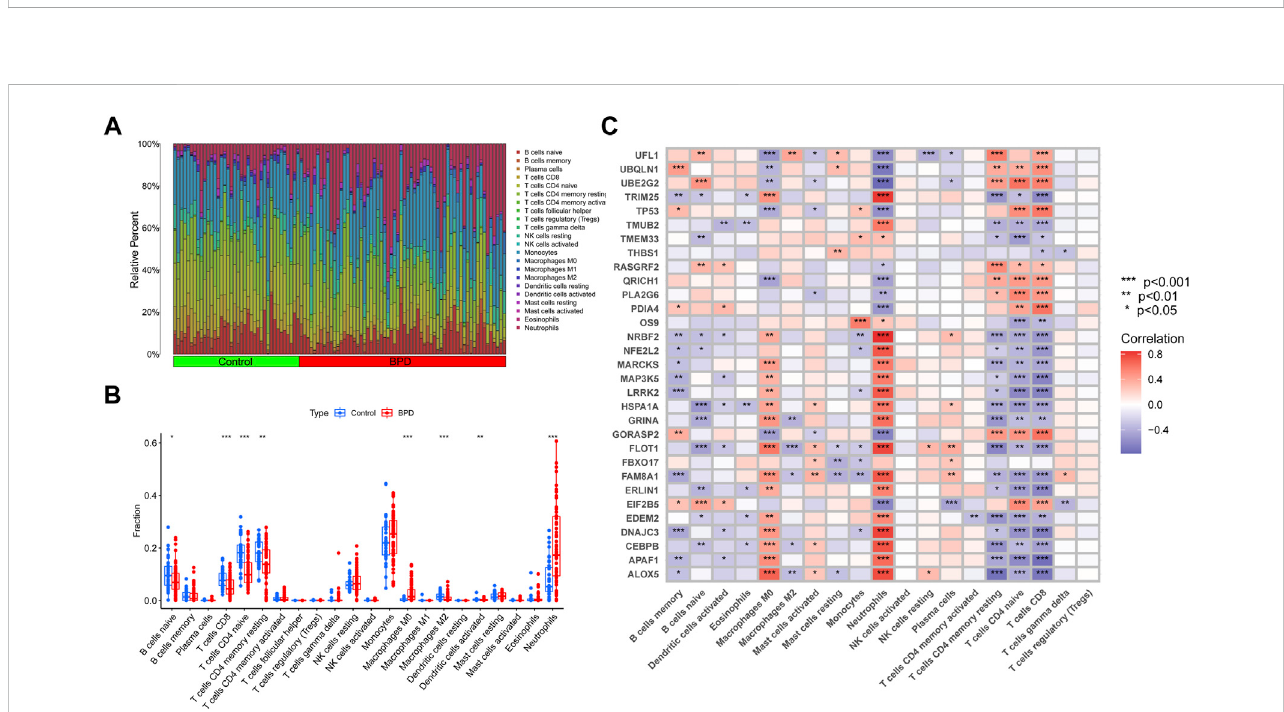
FIGURE 2 Identi fi cation of molecular and immune characteristics between BPD and control samples. (A) The relative abundances of 22 in fi ltrated immune cells between BPD and control samples. (B) Boxplots showed the differences in immune in fi ltrating between BPD and control samples. (C) Correlation analysis between DE-ERSGs and in fi ltrating immune cells. * p < .05, ** p < .01, *** p <